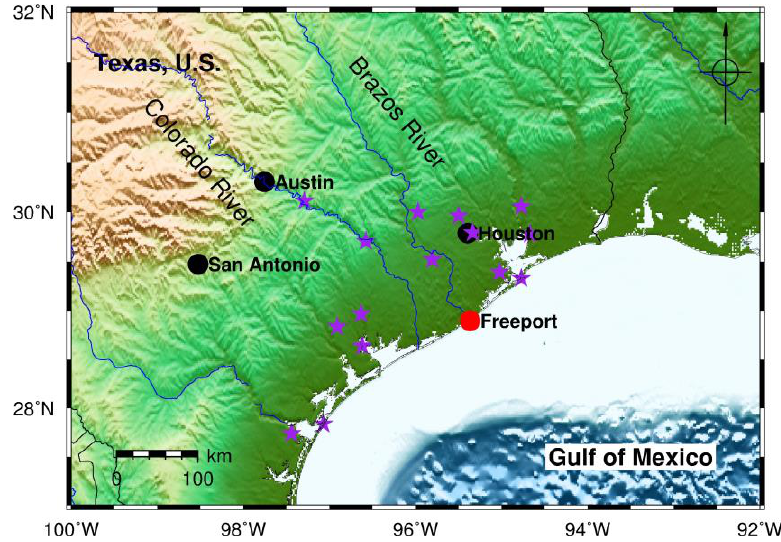
Figure 1. Map showing the location of the study area in Freeport, Texas, USA. Purple stars represent Continuously Operating Reference Stations (CORS) used by the Online Positioning User Service (OPUS) for solving the positions of the scanner according to 15 to 30-min static GPS observations.